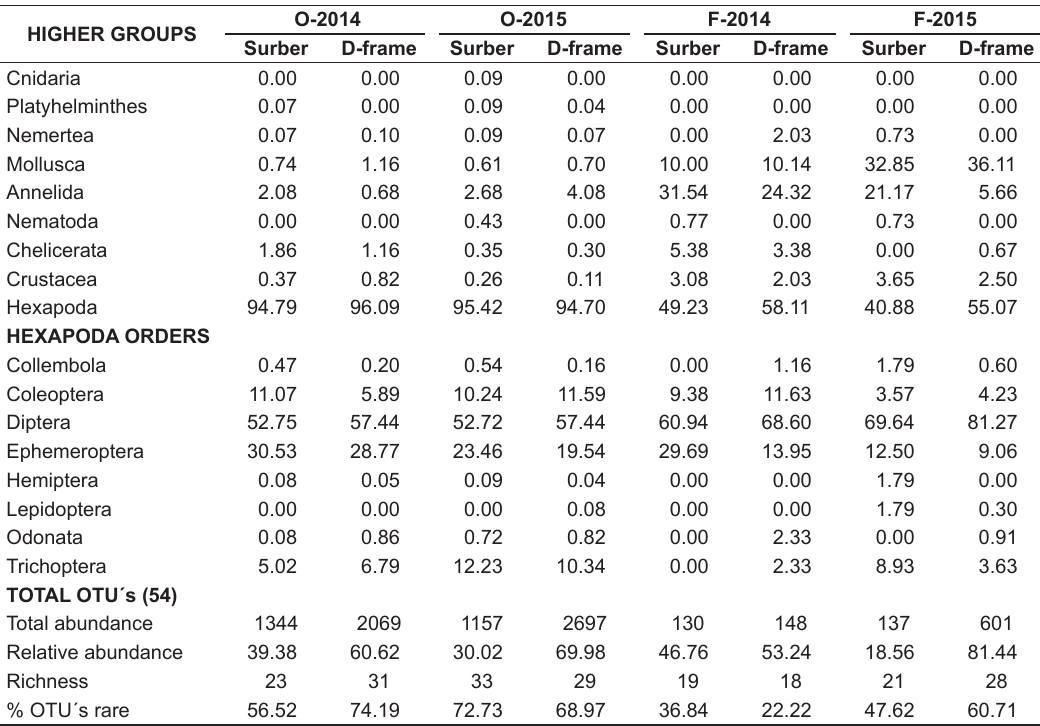
Table 2. Relative abundance (%) of benthic invertebrates sampled in two reaches of Farias stream (O- open, F- forest) in 2014 and 2015, using two samplers (Surber and D-frame net). Data presented for the higher taxonomic groups, for the Hexapoda orders and for the total OTU’s sampled (rare = abundance <1%). HIGHER